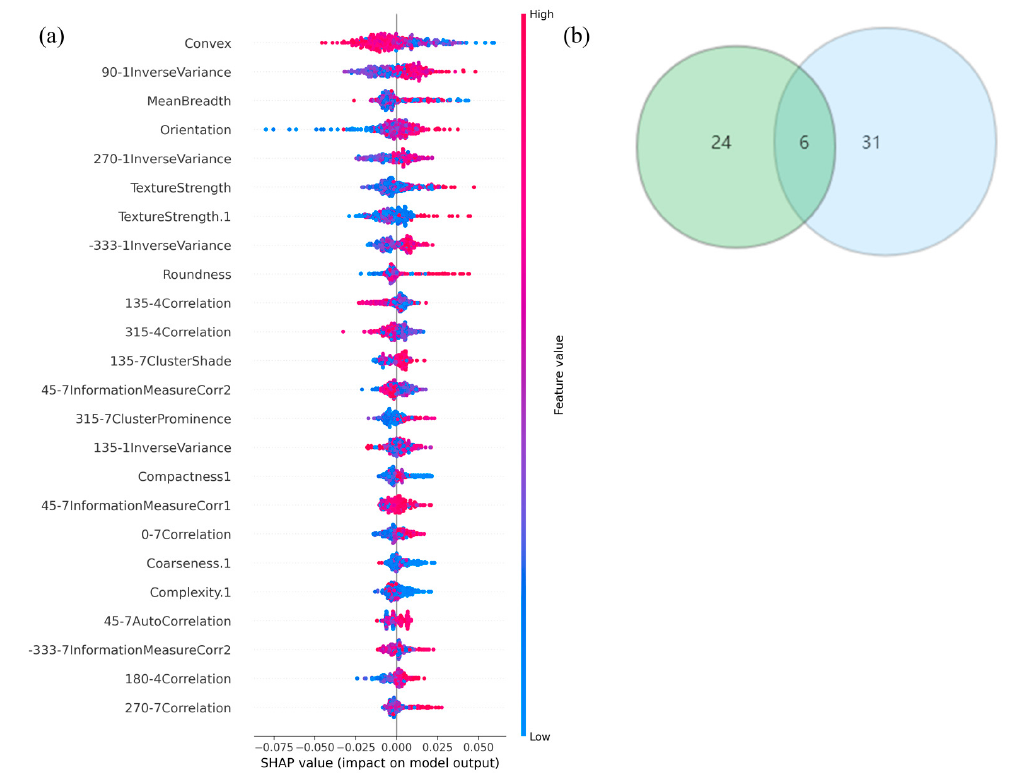
Figure 5. ( a ) The Shapely-value ranking of every single feature. ( b ) Six common radiomics features between PCA and LASSO features, respectively.